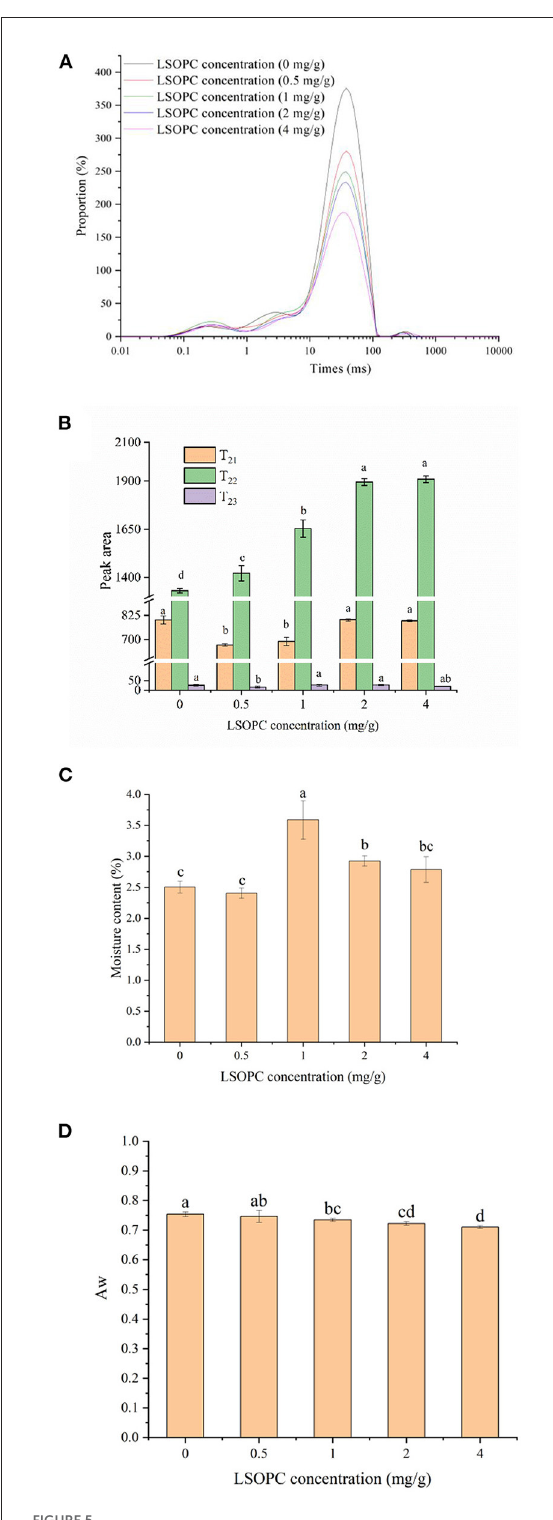
FIGURE5 Effect of LSOPC on relaxation time (A) . Effect of LSOPC on peak area (B) . Effect of LSOPC on moisture content (C) . Effect of LSOPC on Aw (D) . Significant differences ( p < 0.05) of data values were indicated by different letters.